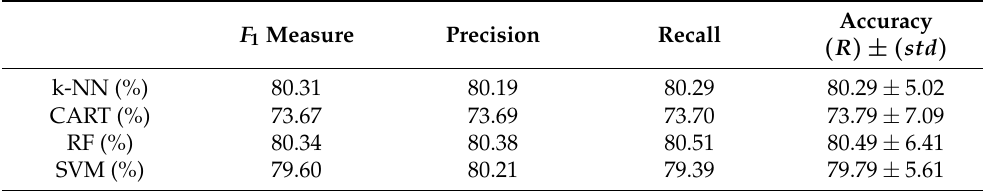
Table 3. F 1 -measure per class, F 1 -measure, precision, recall and average of accuracy rates ( R ) and its standard deviation ( std ) for each model (raw).